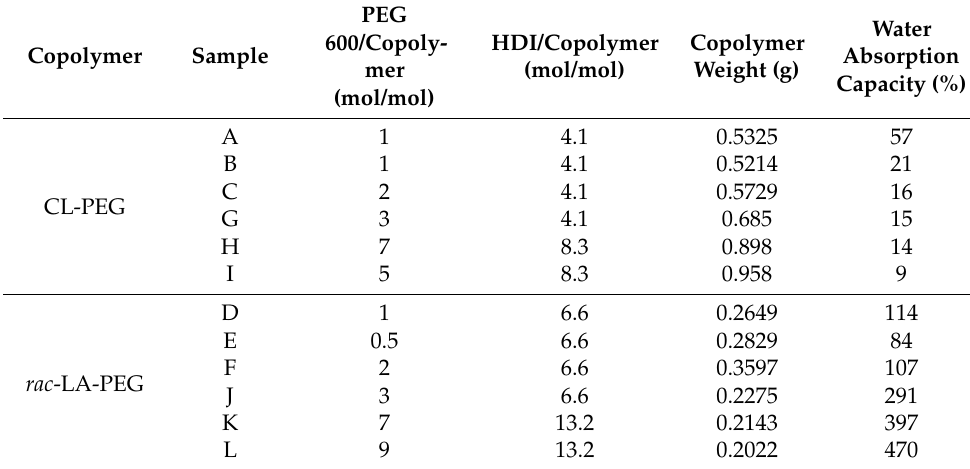
Table 5. Crosslinking reaction parameters.